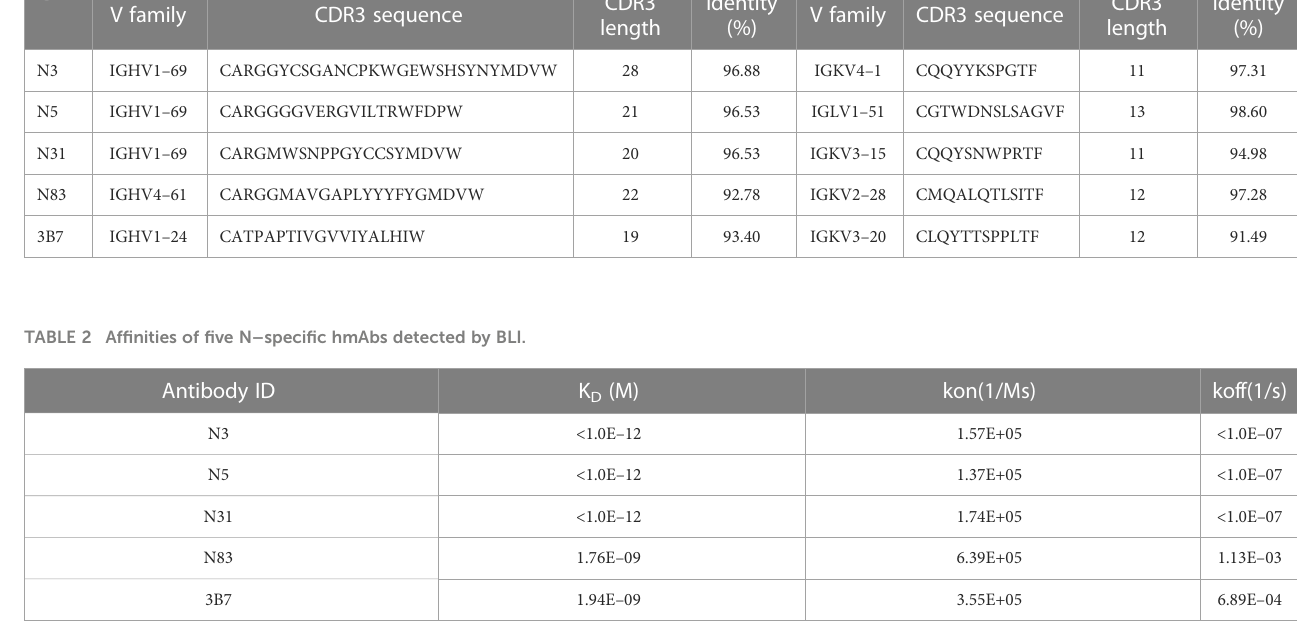
TABLE 1 Gene characteristics of fi ve N – speci fi c mAbs derived from two convalescent COVID – 19 patients. Heavy chain Ab ID